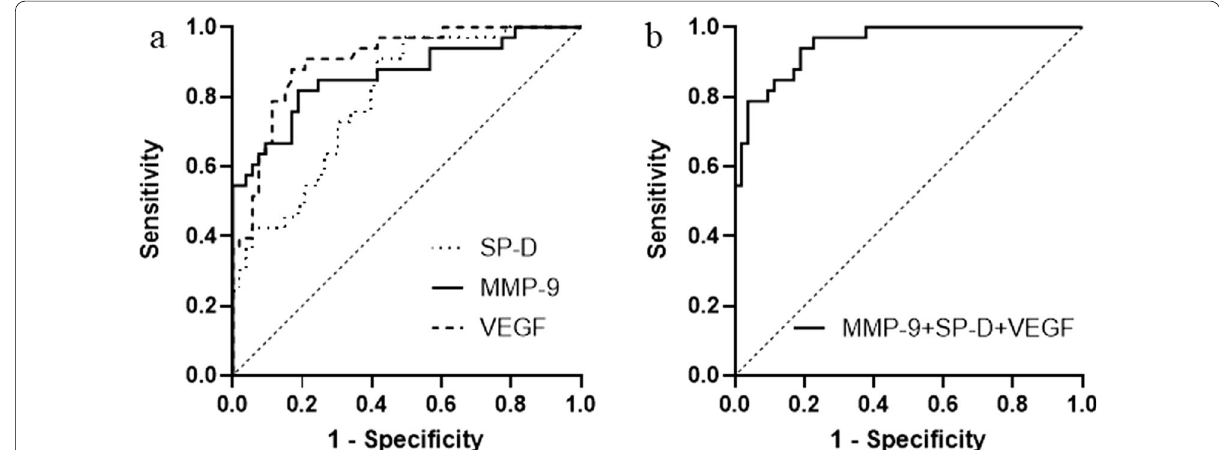
Fig. 3 ROC curves of the three biomarkers for the independent ( a ) and combined ( b ) diagnosis of